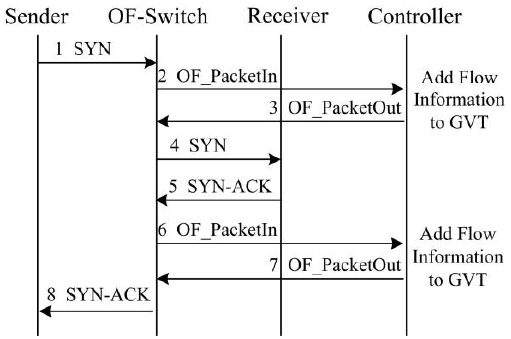
Figure 5. GVT entry generation with the TCP connection procedure.